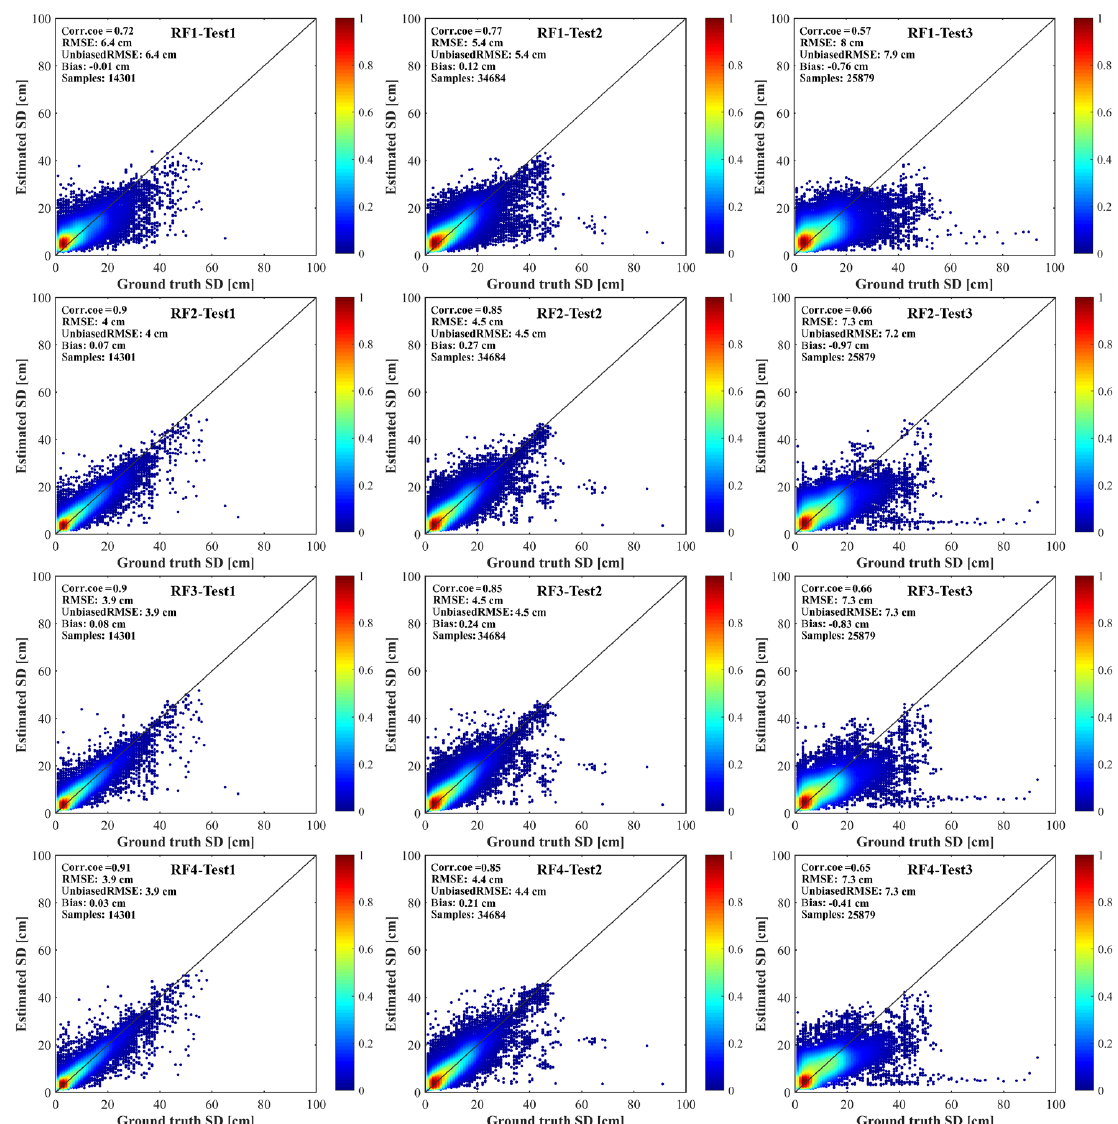
Figure 6. The color–density scatterplots of the estimated snow depth with four fitted RF algorithms and the ground truth snow depth. The four trained RF algorithms (RF1, RF2, RF3, RF4) were evaluated with three validation datasets (Test1, Test2,